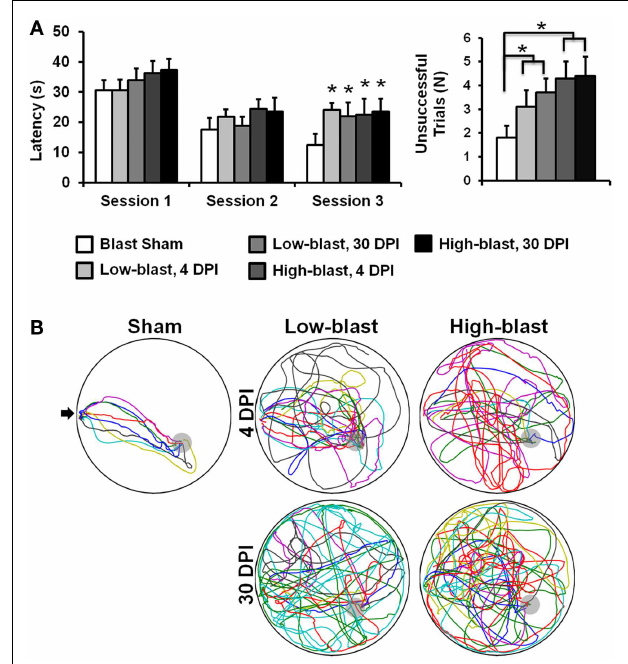
FIGURE 3 | Morris water maze . Memory and learning deficits were evident in the blast-exposed animals compared to sham animals (A) . Swim path traces from the final trial (B) , with each animal shown in a different color, reveal the difficulties in finding the hidden platform (gray) in the blast-exposed animals compared to the sham animals.The entry point is indicated with an arrow. Error bars indicate SEM. * p <